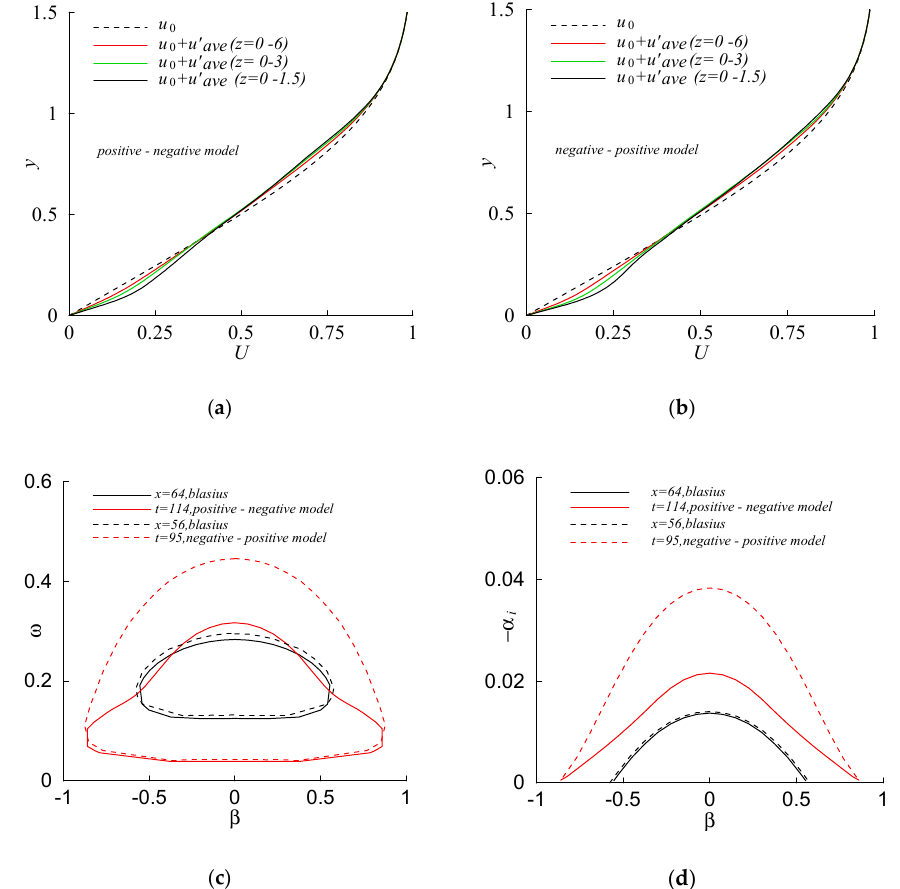
Figure 6. Mean stream-wise velocity and flow stability: ( a ) t = 114; ( b ) t = 95; ( c ) neutral curve;